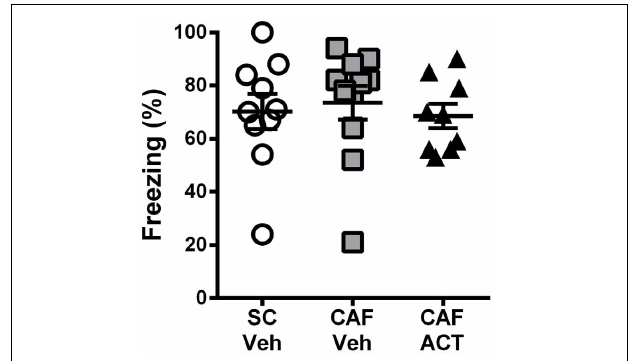
FIGURE 4 | Effect of CAF diet and ACT-335827 on cognition in week 16. Percentage of time spent freezing over a 10min test of contextual conditioned fear. Mean ± s.e.m. ( n = 9–11 per group). No statistical difference between groups was revealed. ( SC , standard chow; CAF , cafeteria diet; Veh , vehicle; ACT , ACT-335827).